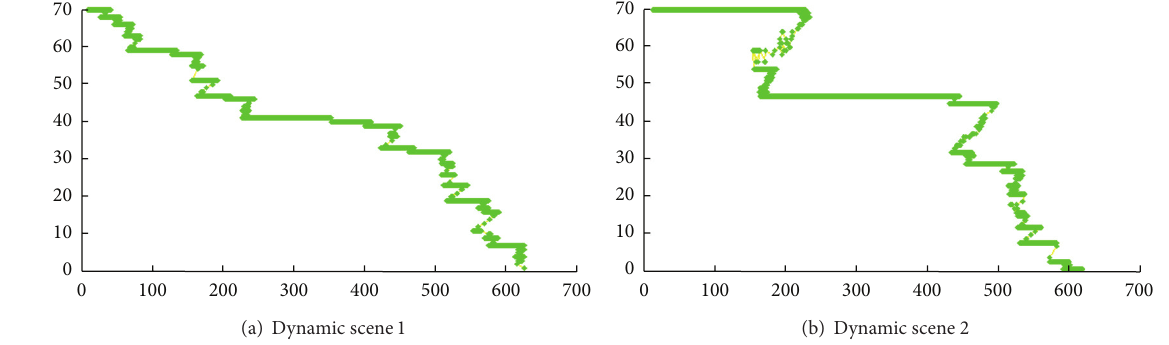
Figure 10: Cut paths for forming the optimum output